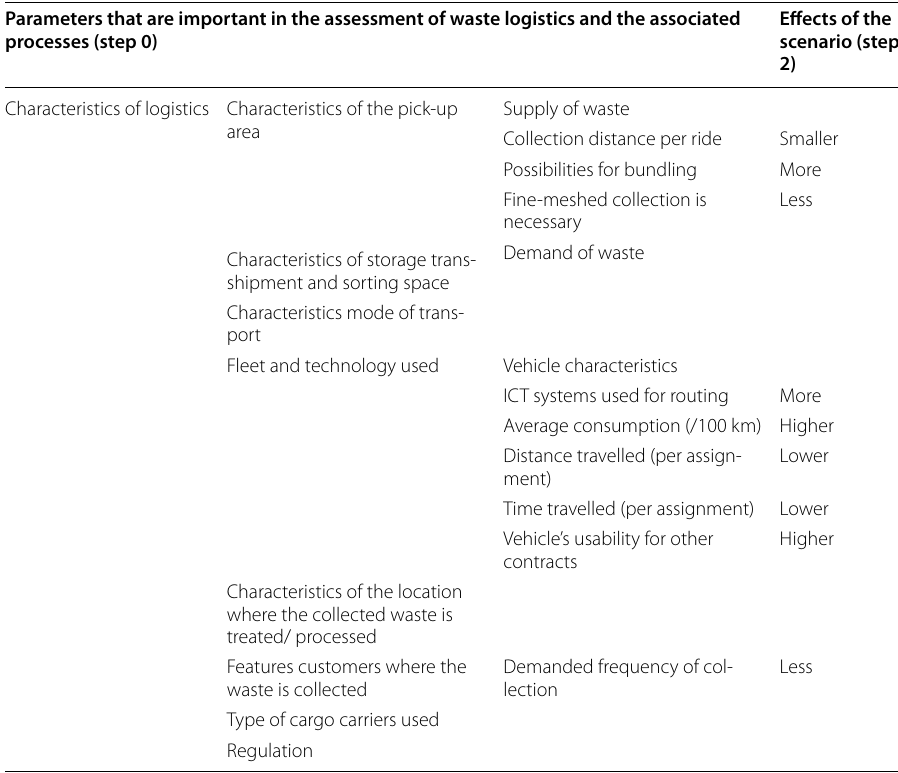
Table 3 Results step 3 case 1